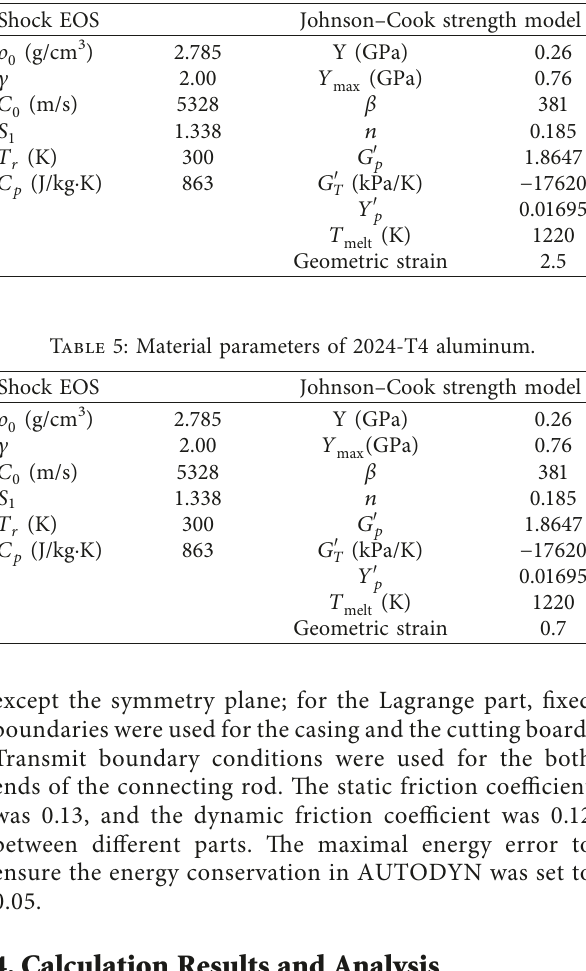
Table 4: Material parameters of V250 stainless steel. Shock EOS Johnson–Cook strength model